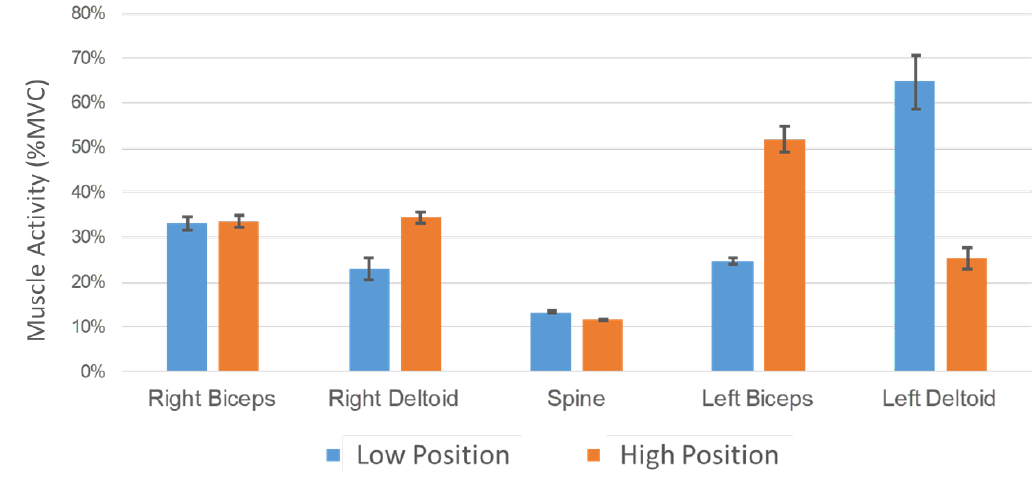
Figure 8. Muscle activity of five body regions by posture.